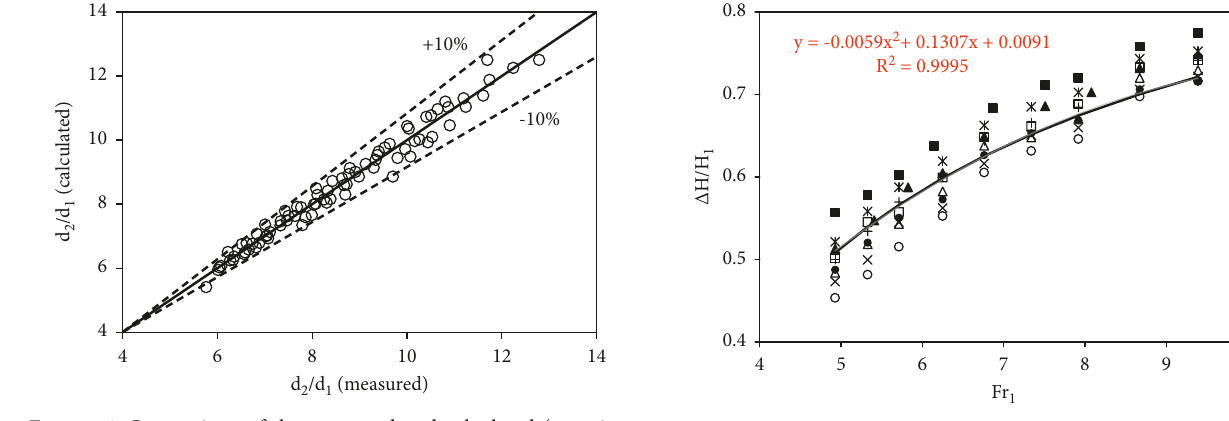
Figure 6: Comparison of the measured and calculated (equation (11)) values of d 2 / d 1 .